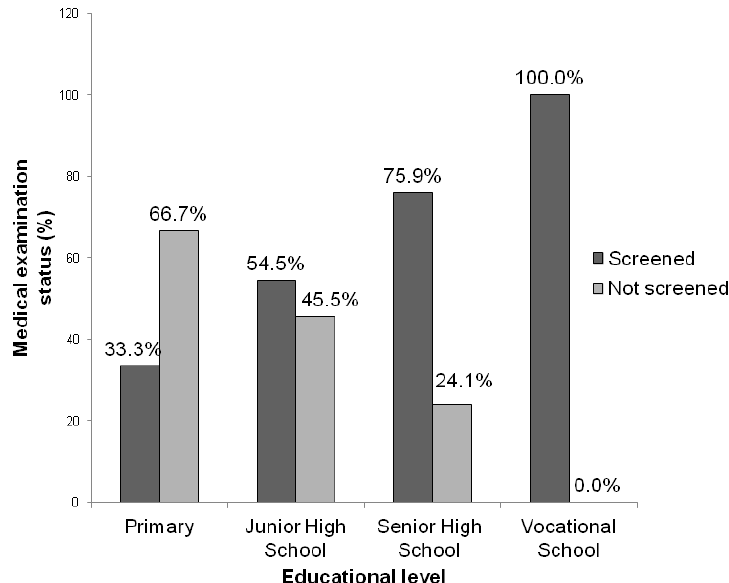
Figure 3. Relationship between vendors’ educational level and status of medical